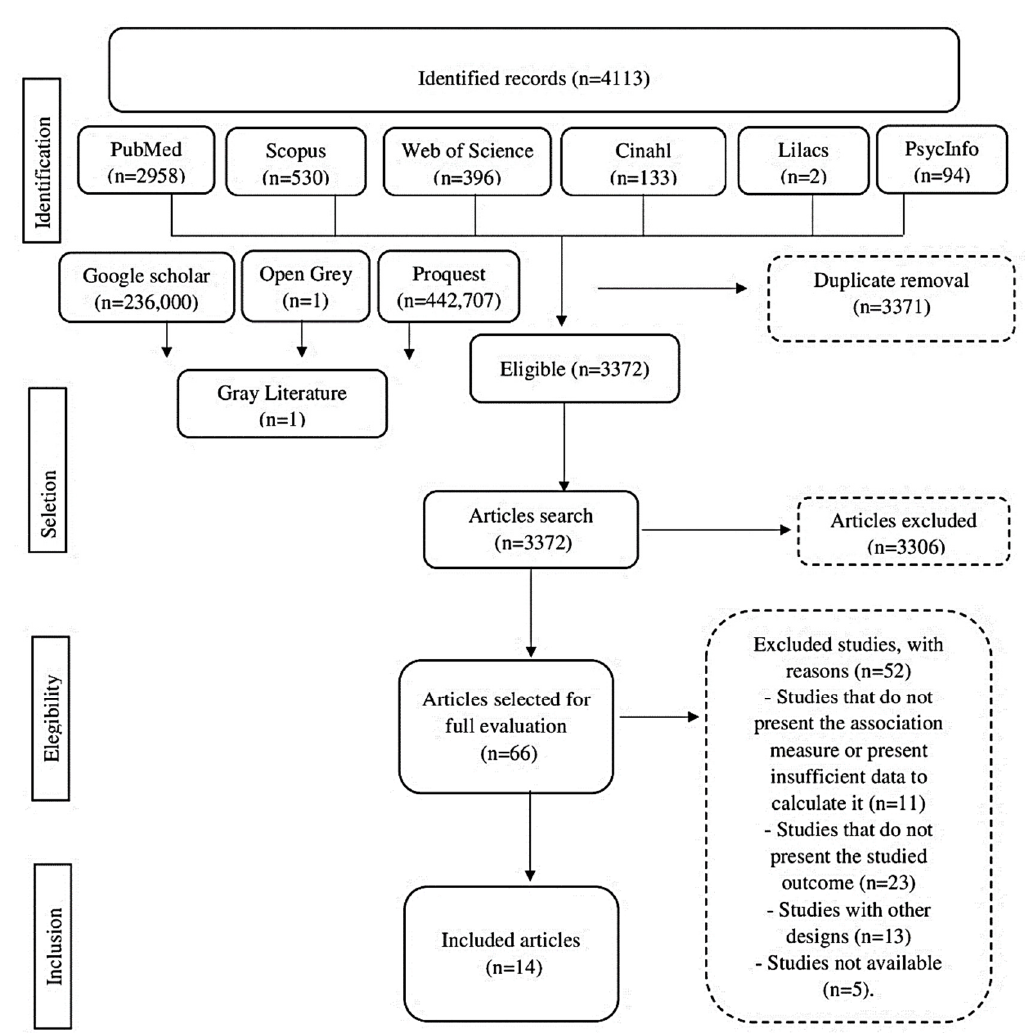
Figure 1. Flowchart of the selection of articles included in the review.